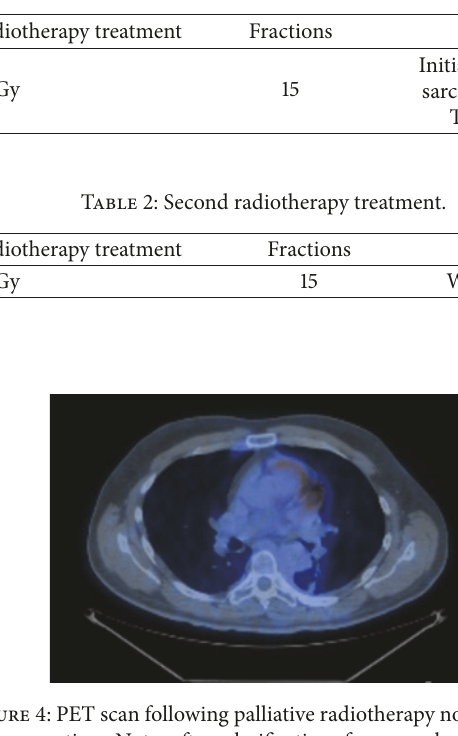
Table 1: First radiotherapy treatment.